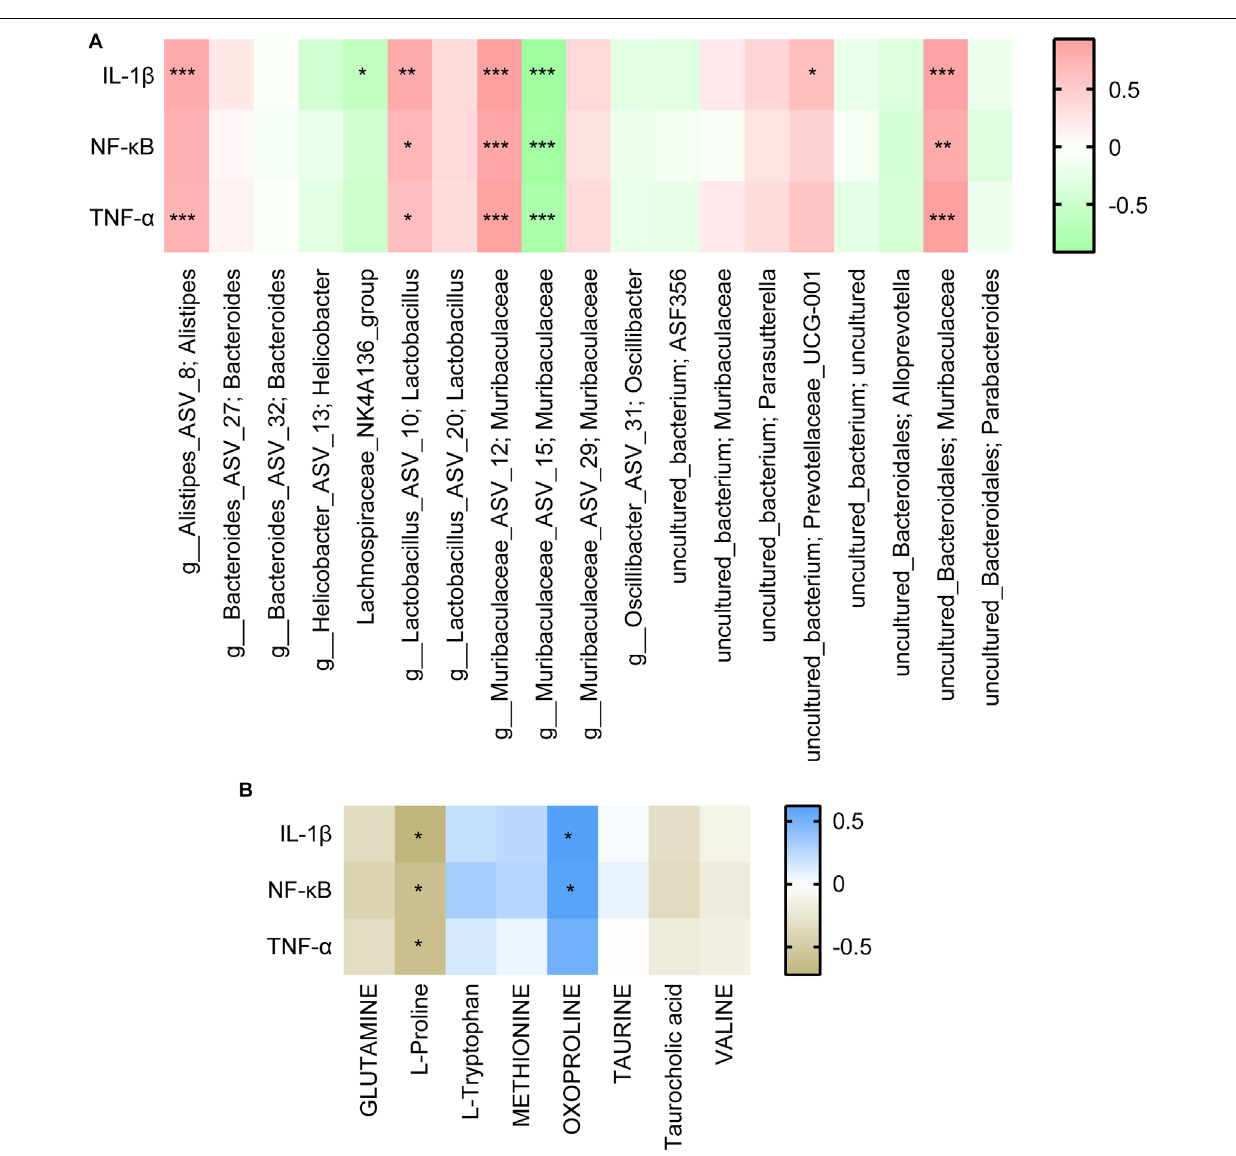
FIGURE 8 | Correlation analysis of inflammatory factors with (A) the top 20 gut species and (B) differential metabolites. Each block represents a correlation, and the color of the block represents the strength of the correlation. A high absolute value of R value indicates a strong correlation. * P < 0.05. ** P < 0.01. *** P <